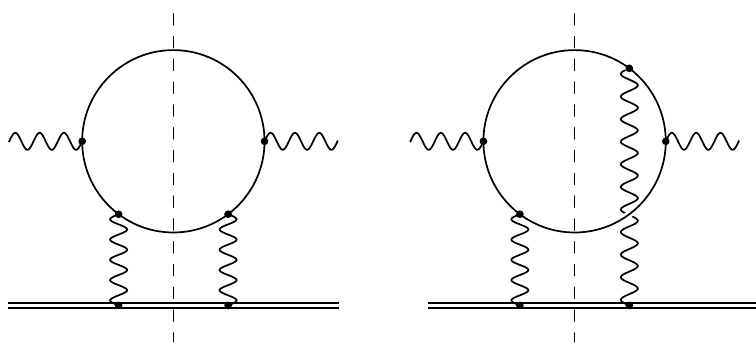
Figure 1 . Cut diagrams for the calculation of the total cross section of e + e (cid:0) pair production by a photon in the (cid:12)eld of nucleus. Cut thin line denotes the cut propagators (cid:0) 2 (cid:25)i(cid:14) ( p 2 (cid:0) m 2 )(^ p + m ) of the electron, cut double line denotes the cut propagator (cid:0) 2 (cid:25)i(cid:14) (2 q (cid:1) v ) = (cid:0) 2 (cid:25)i(cid:14) (2 q 0 ) of a heavy particle, interaction vertex with the heavy particle is (cid:0) iv (cid:22) ( v = (1 ; 0 ) is a four-velocity of the